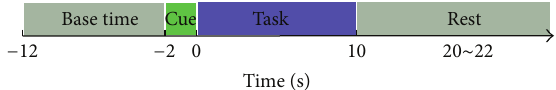
Figure 1: The experiment paradigm used in the